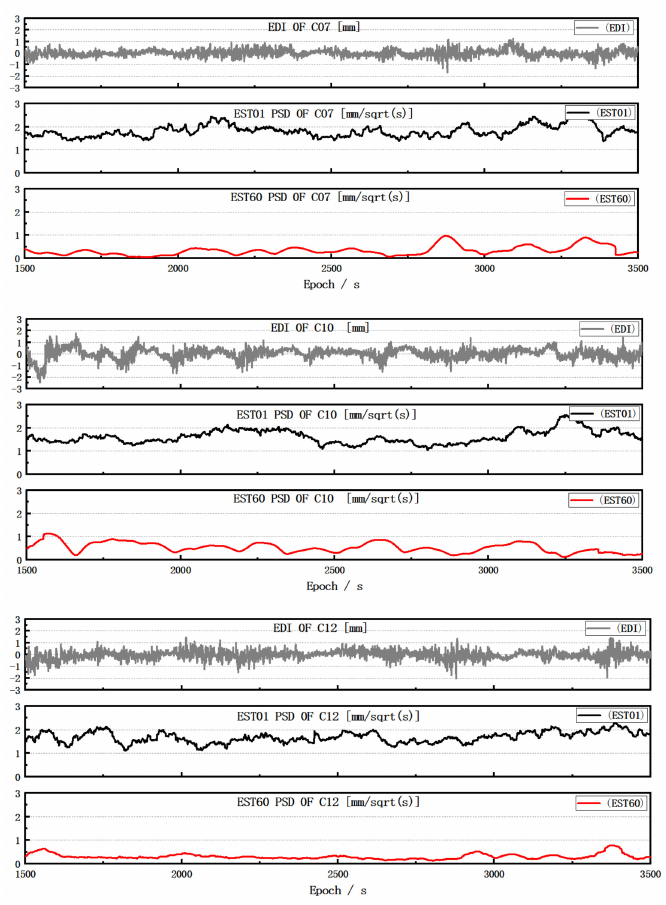
Figure 12. The time series of EDI and estimated PSD used in EST01 and EST60 for satellite C07, C10 and C12 from top to bottom.